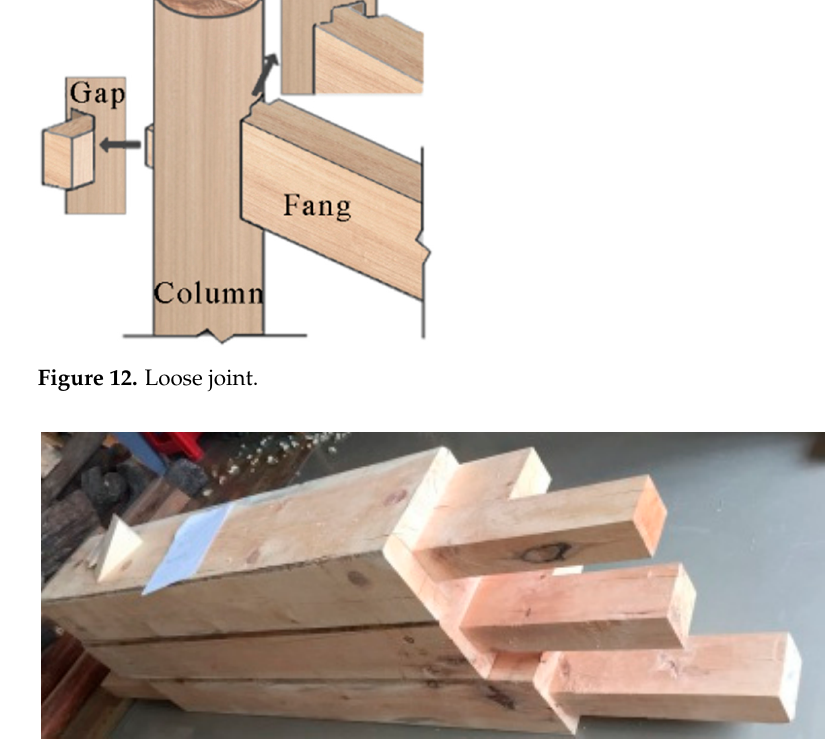
Figure 13. Fang models of the loose joint.